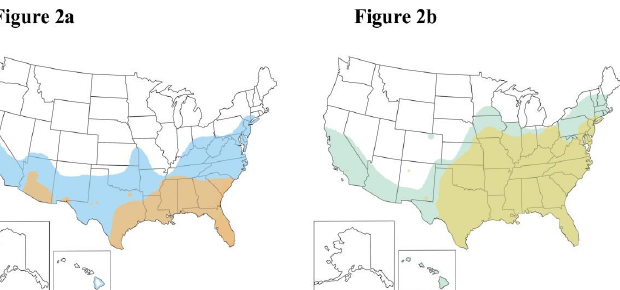
Figure 2a,b. In April 2015, the CDC updated its vector surveillance maps to depict that both A. aegypti and A. albopictus are now believed to inhabit a wider range of distribution in the U.S. Figure 2a illustrates the expansion of territory covered by A. aegypti ; Figure 2b illustrates the expansion of A. albopictus . The range of both mosquitos has spread significantly to the north and west. Although the significance of this expansion in epidemiologic terms is unclear, it may place a greater proportion of the population at risk for exposure to emerging arboviruses such as Zika, particularly during warmer